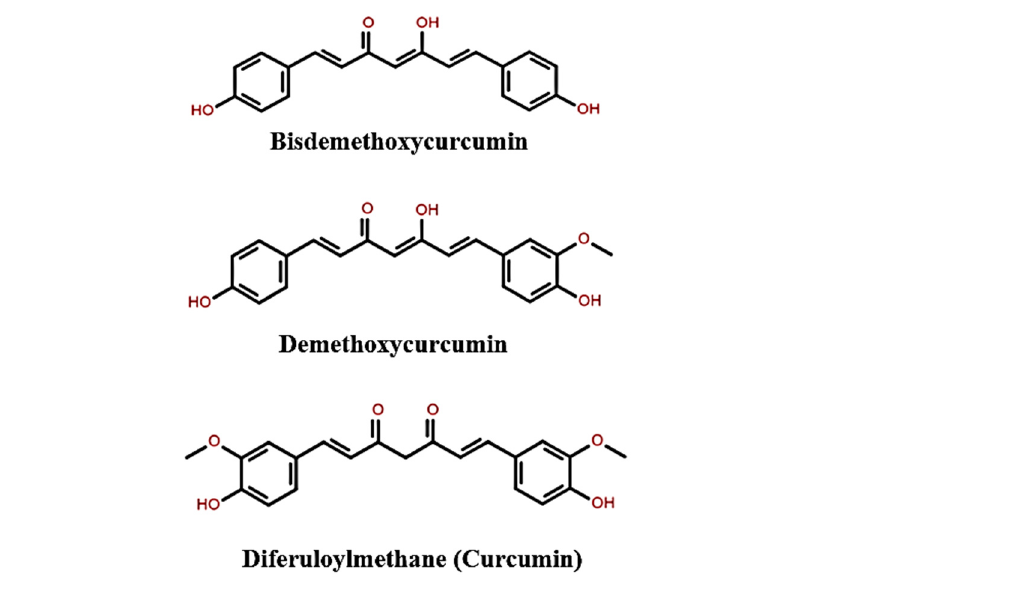
Figure 7. Chemical structures of bisdemethoxycurcumin, demethoxycurcumin, and diferuloylmethane (curcumin). Drawn using ChemSpider and available online: http://www.chemspider.com/Chemical-Structure.1906.html (accessed on 30 May 2021).